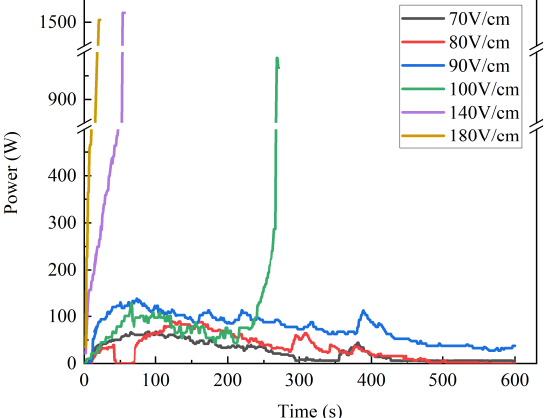
Figure 6. Variation in heat generation power with time under different electric field intensities.